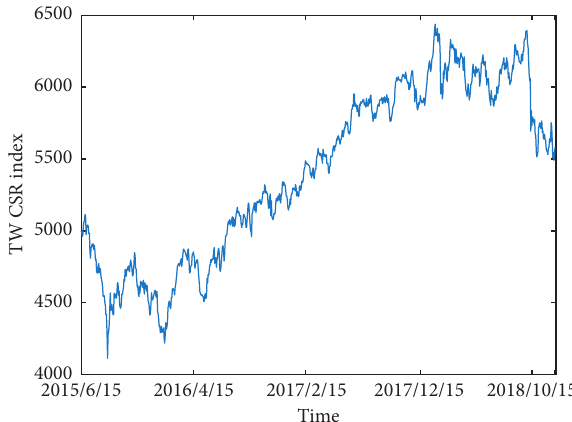
Figure 1: Taiwan CSR index. The statistical characteristics are as follows: the mean is 5412, the standard deviation is 600.182, and the variance is 360220, for a total of 863 datasets. There are 863